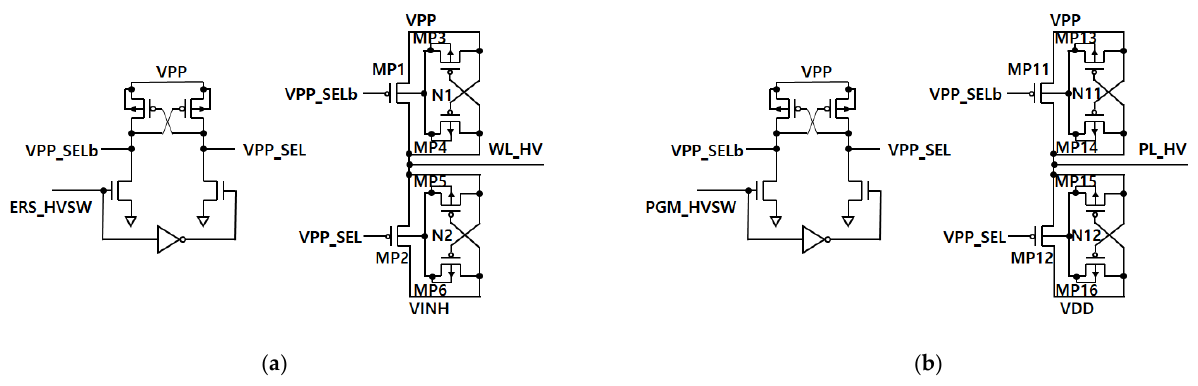
Figure 9. HV switching circuit used in synaptic core circuit: ( a ) WL_HV switching circuit; ( b ) PL_HV switching circuit.